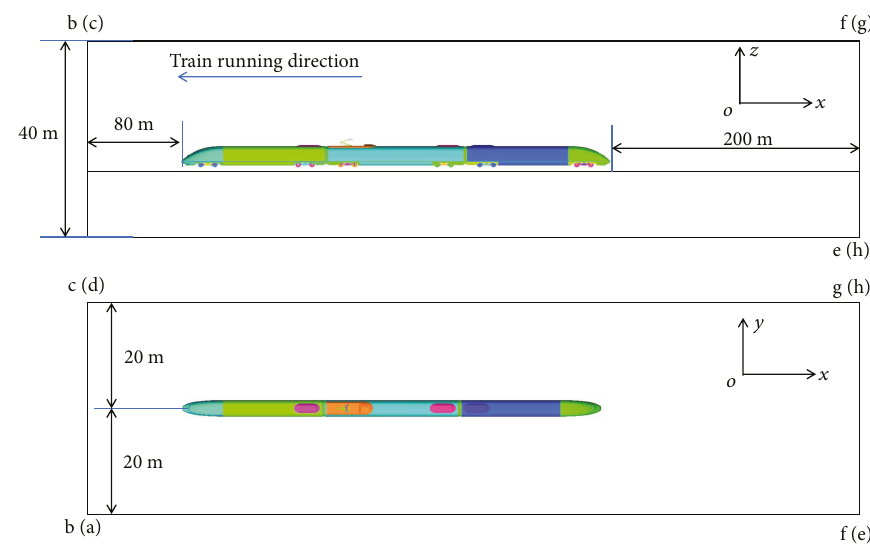
Figure 3: Computation domain of high-speed railways on the bridges.